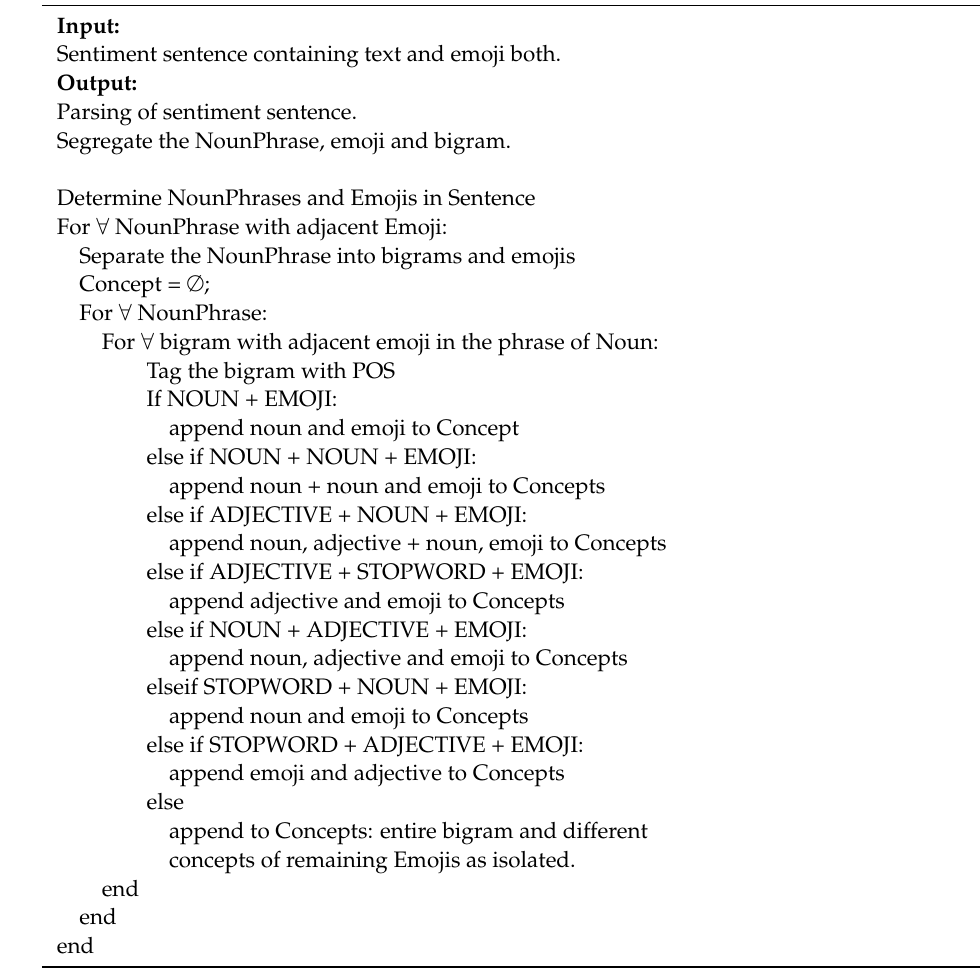
Algorithm 2: Sentiment containing both Text and